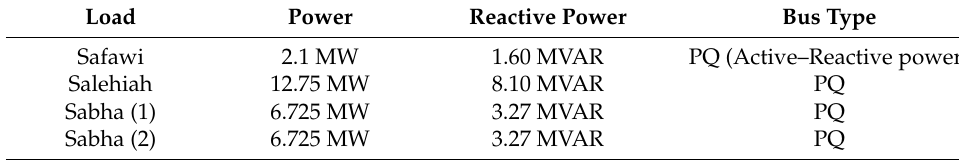
Table 3. Load data in JSDN.